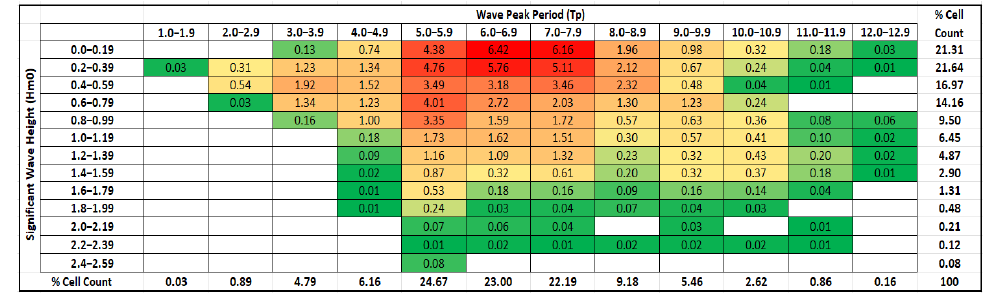
Figure 6. Joint Distribution Percentage of Mantanani Island.